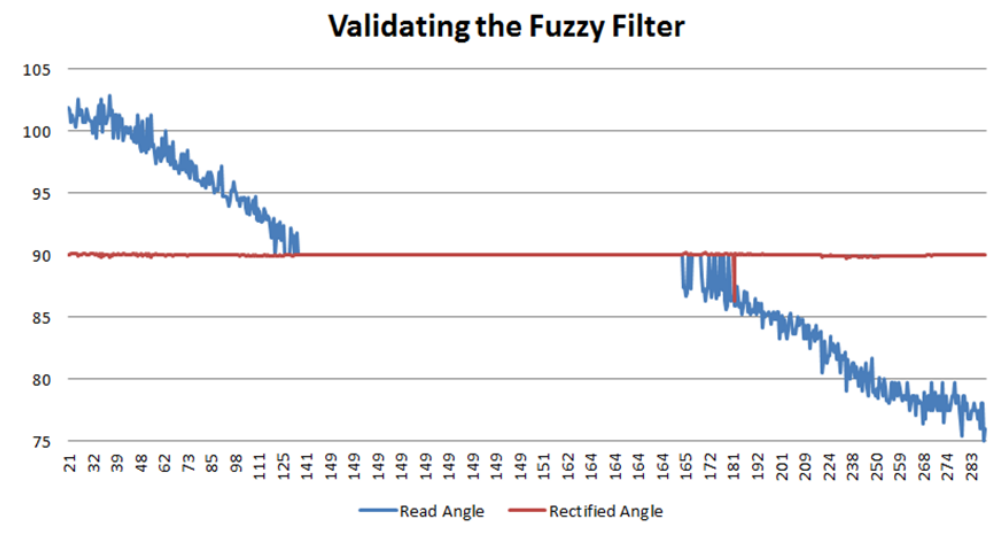
Figure 14. Results from the first